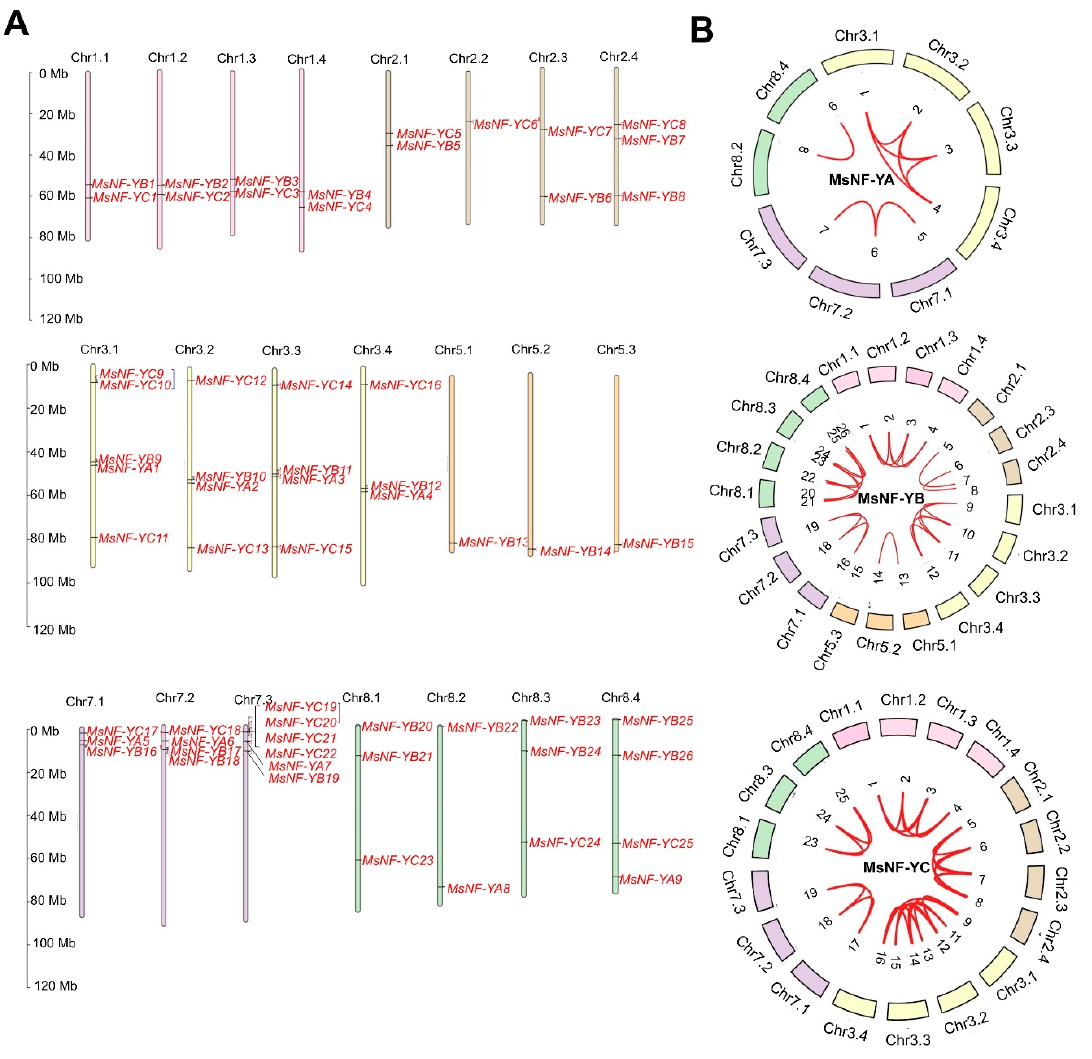
Figure 4. Genome locations and duplication analysis of 60 MsNF-Y genes in the alfalfa genome. ( A ) The physical locations of the 60 MsNF-Y genes. The blue lines connect the corresponding two pairs of paralogous genes in the same chromosome. ( B ) Duplication analysis of MsNF-Y genes on different chromosomes. From left to right are the NF-YA, NF-YB, and NF-YC subfamilies.